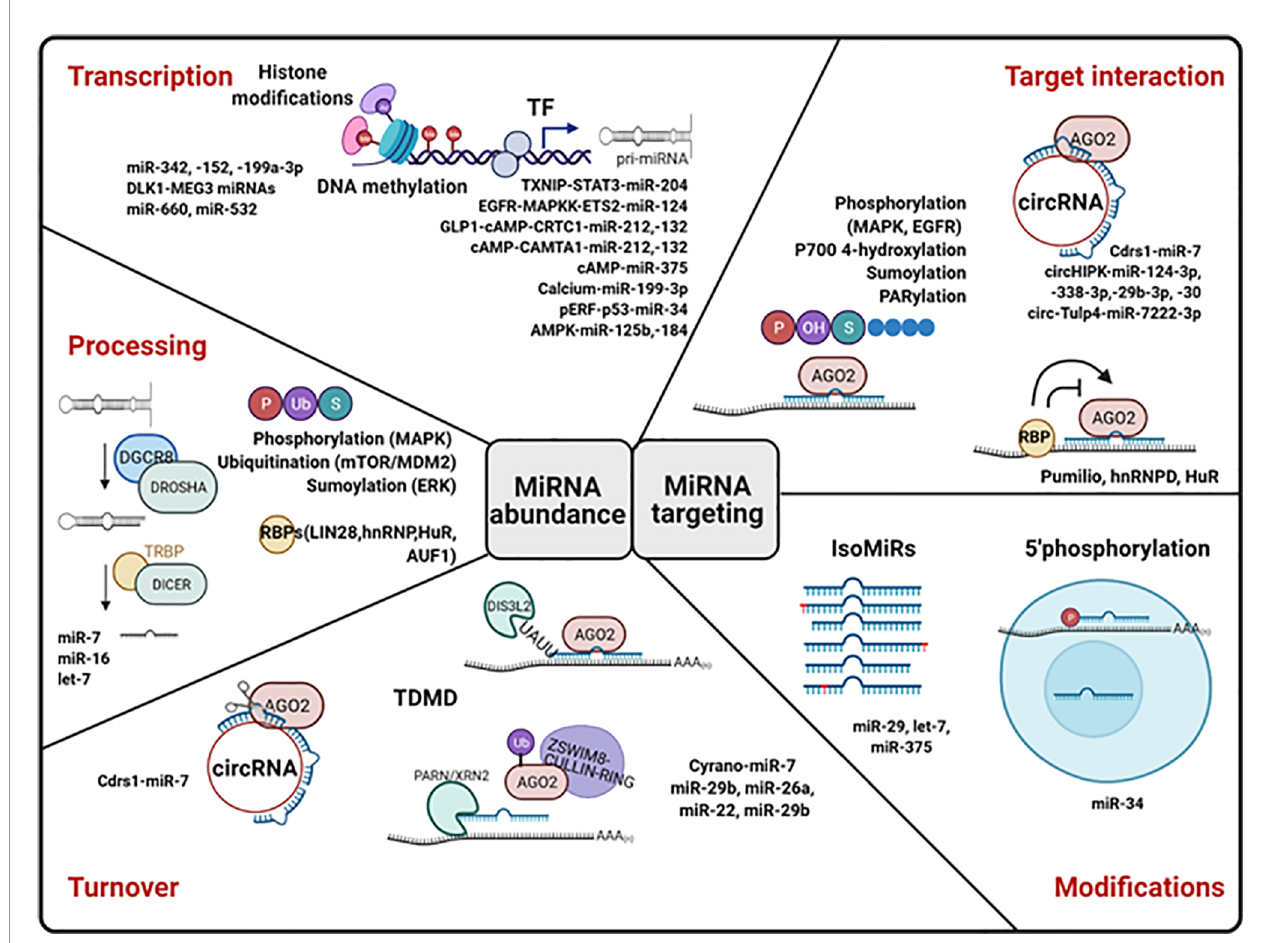
FIGURE 4 | Molecular mechanisms of miRNA regulation. MiRNA levels can be control at the level of transcription, processing, and stability. MiRNA transcription is regulated by epigenetic modi fi cations (histone modi fi cations and DNA methylation) and by the action of transcription factors (TF). The action of proteins important for RNA processing is regulated by post-translational modi fi cations (P, phosphorylation; U, Ubiquitination; S, Sumoylation) and by RNA-binding proteins (RBPs). Circular RNAs (cirRNAs) can promote miRNA degradation. TDMD, target-directed miRNA degradation, can occur dependently or independently of miRNA tailing and trimming. The capacity of miRNAs to bind and repress their targets can be modulated by miRNA modi fi cations and by RBPs, lncRNAs, and circRNAs. Examples of islet miRNAs regulated at each level are included in the fi gure. Created with Biorender.com. See text for more